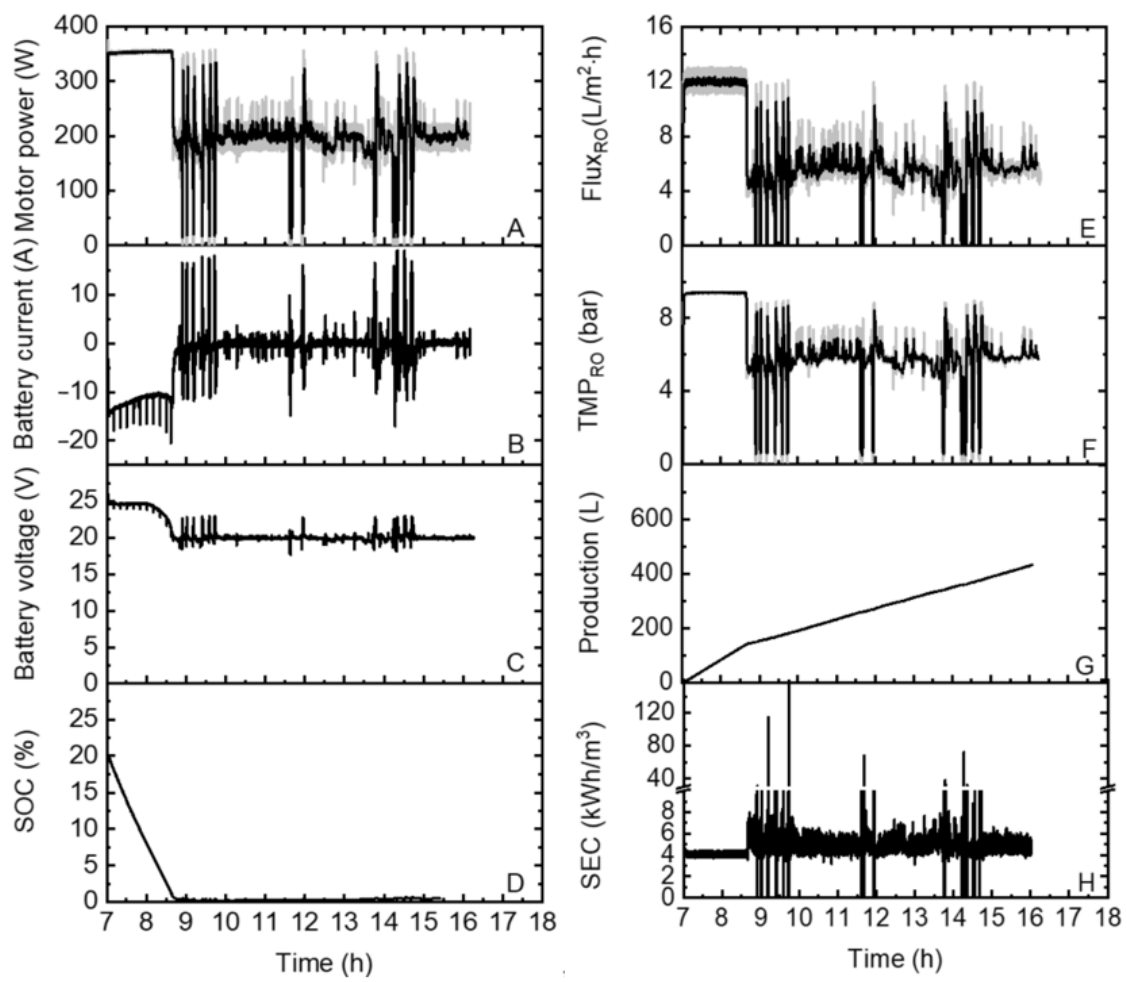
Figure A5. The performance of the PV-membrane system on the “partly cloudy day” equipped with batteries at 20% SOC, indicating ( A ) the pump power, ( B ) battery current, ( C ) battery voltage, ( D ) SOC, ( E ) RO flux, ( F ) TMP RO , ( G ) production and ( H ) SEC. Note that the black curves on graphs ( A ), ( E ) and ( F ) are the moving average values of 10